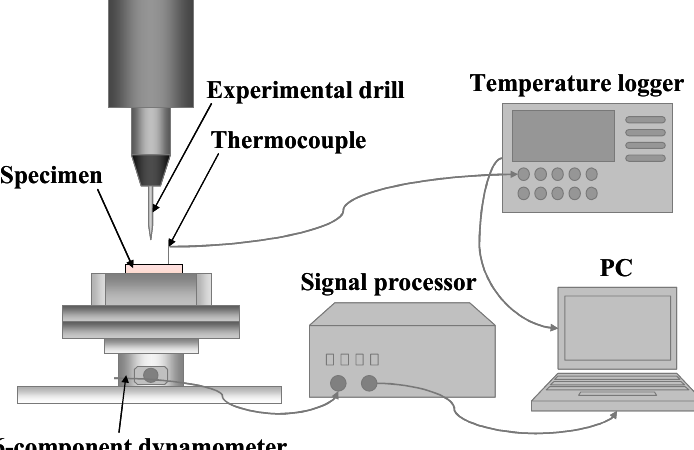
Figure 2 Experimental setup used for the drilling test.